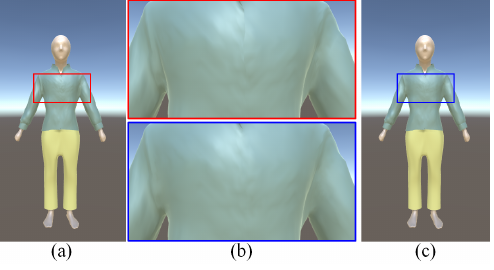
Figure 7. Effect of interpolation methods: ( a ) linear interpolation; ( b ) zoom in; ( c ) dual quaternion